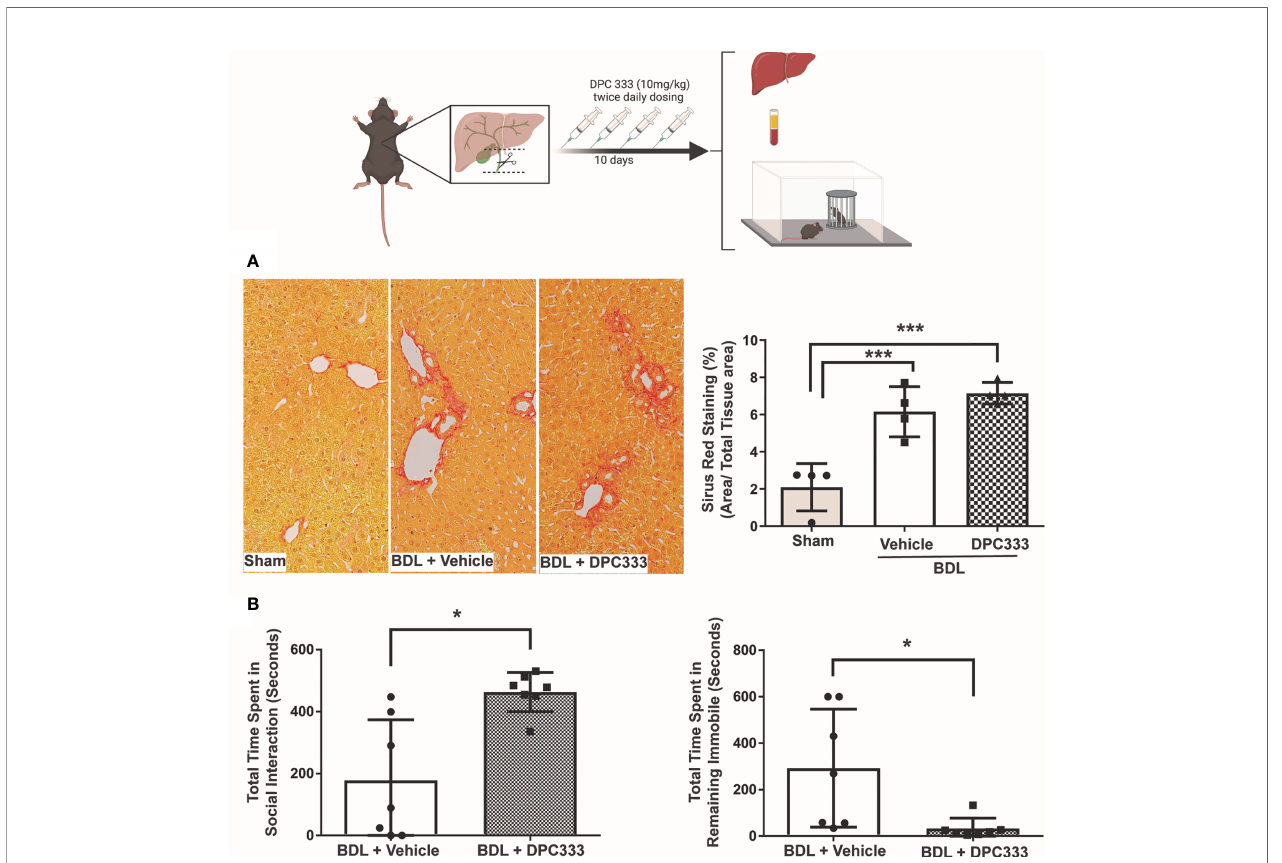
FIGURE 3 | Inhibition of ADAM17 enzymatic activity attenuates sickness behavior development in BDL mice. Diagram of experimental design depicting bile duct ligation (dotted line) with resection in between ligatures in BDL mice. Twice daily treatment with DPC 333 (10 mg/kg) was provided via intraperitoneal injection. Mice were overtly cholestatic 10 days post surgery at which point experimentation was completed. (A) DPC 333 treated BDL mice did not result in a signi fi cant reduction in liver fi brosis as shown by Sirius red staining and blinded quanti fi cation. (B) Improvement in BDL-associated sickness behaviors in day 10 DPC 333-treated vs vehicle-treated BDL mice as re fl ected by a signi fi cant increase in the time DPC 333-treated BDL mice spent engaging in social investigative behavior vs vehicle- treated BDL mice, and a signi fi cant reduction in the time DPC 333-treated BDL mice spent remaining immobile compared to vehicle-treated BDL mice. *p ≤ 0.05. Graphs show the mean ± SEM of n = 7 DPC 333-treated BDL mice, and n = 7 vehicle-treated BDL mice. All experiments were repeated twice with similar results. ***p < or equal to